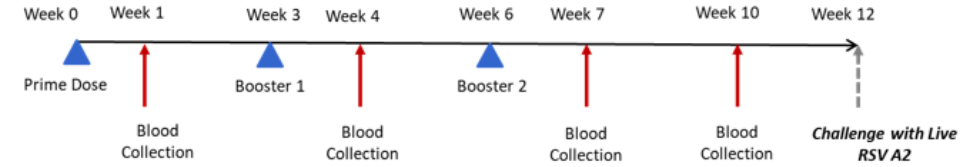
Figure 1. Immunization schedule. A prime dose of 5 µg of RSV-F VLP subunit vaccine was admin- istered to mice on week 0, followed by a booster on weeks 3 and 6. Blood samples were collected and IgG titers were measured on weeks 1, 4, 7, and 10. Live RSV A2 virus challenge was induced intranasally on week 12.